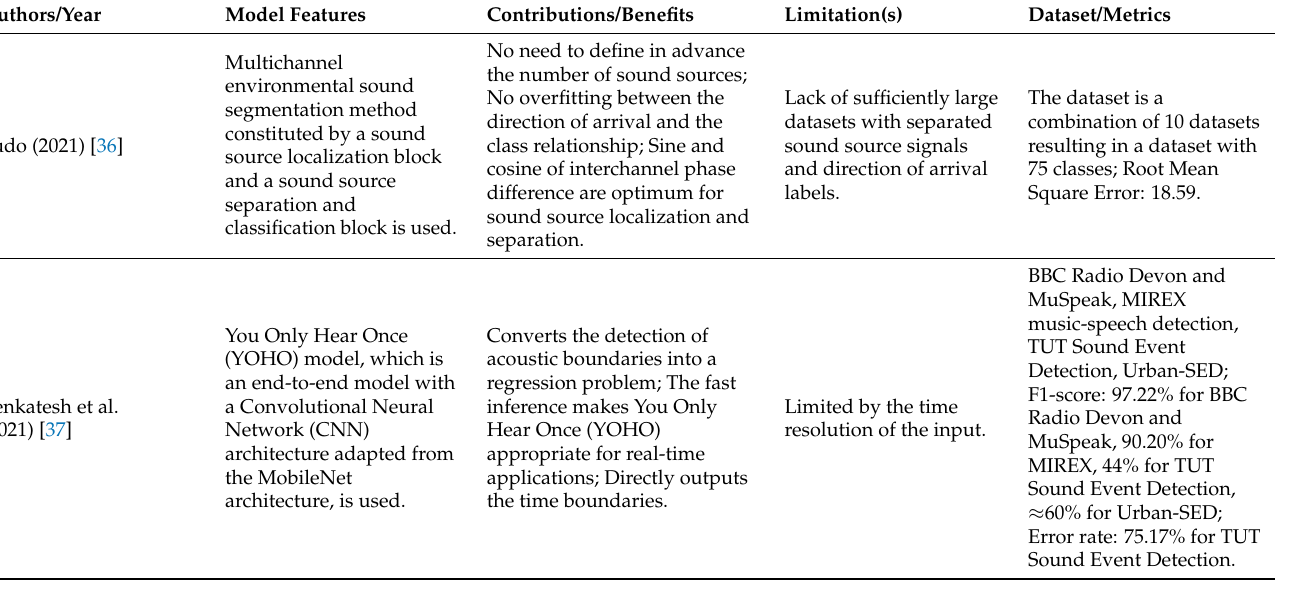
Table 5. Resume of the research articles found on audio segmentation with autoencoder-like